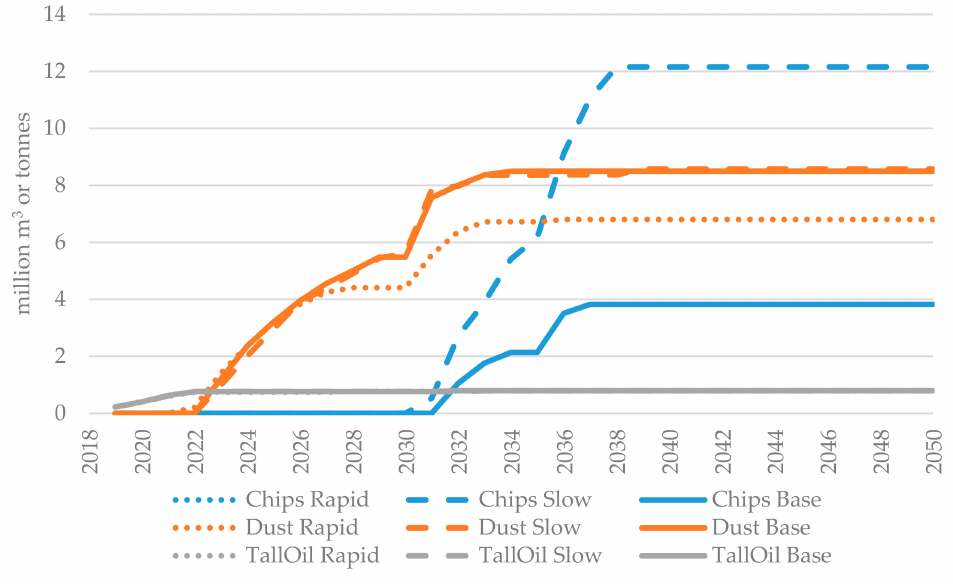
Figure 11. Raw materials used for biofuel production in the different